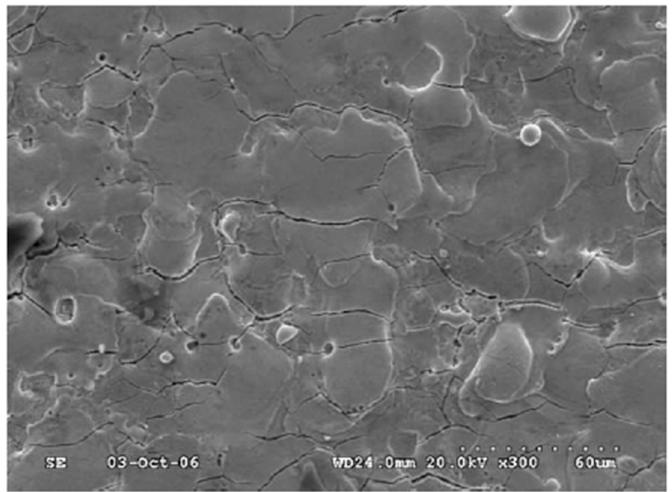
Figure 8. SEM image showing severe cracks formed on SKD11 surface machined using a pulse current of 4 A and pulse-on duration of 16 µs [146].